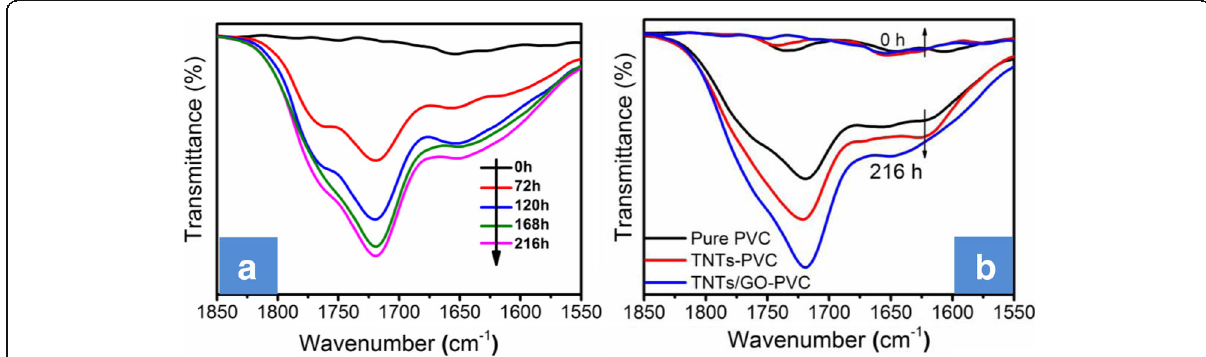
Fig. 12 FTIR spectra of the carbonyl (C=O) groups of TNTs/GO-PVC film versus UV irradiation time ( a ) and before and after photodegradation ( b ). The intensity of the C=O absorption peak of TNTs/GO-PVC film increases continually with increasing irradiation time; it is more pronounced than that for neat PVC film and for TNTs-PVC film. This further demonstrates that the TNTs/GO nano-filler can indeed promote the photo-oxidation reaction of the PVC matrix